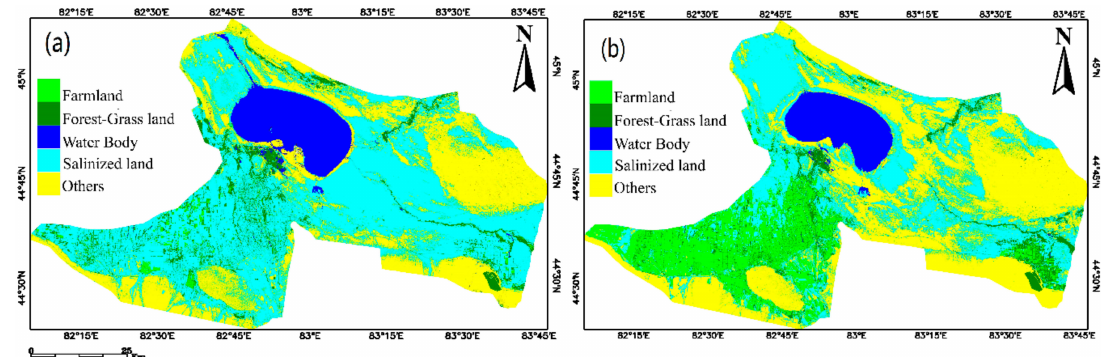
Figure 6. The change in land use/cover of the Ebinur Lake area during the rainy (May) and dry (October) seasons in 2015 ( a ) May; ( b )